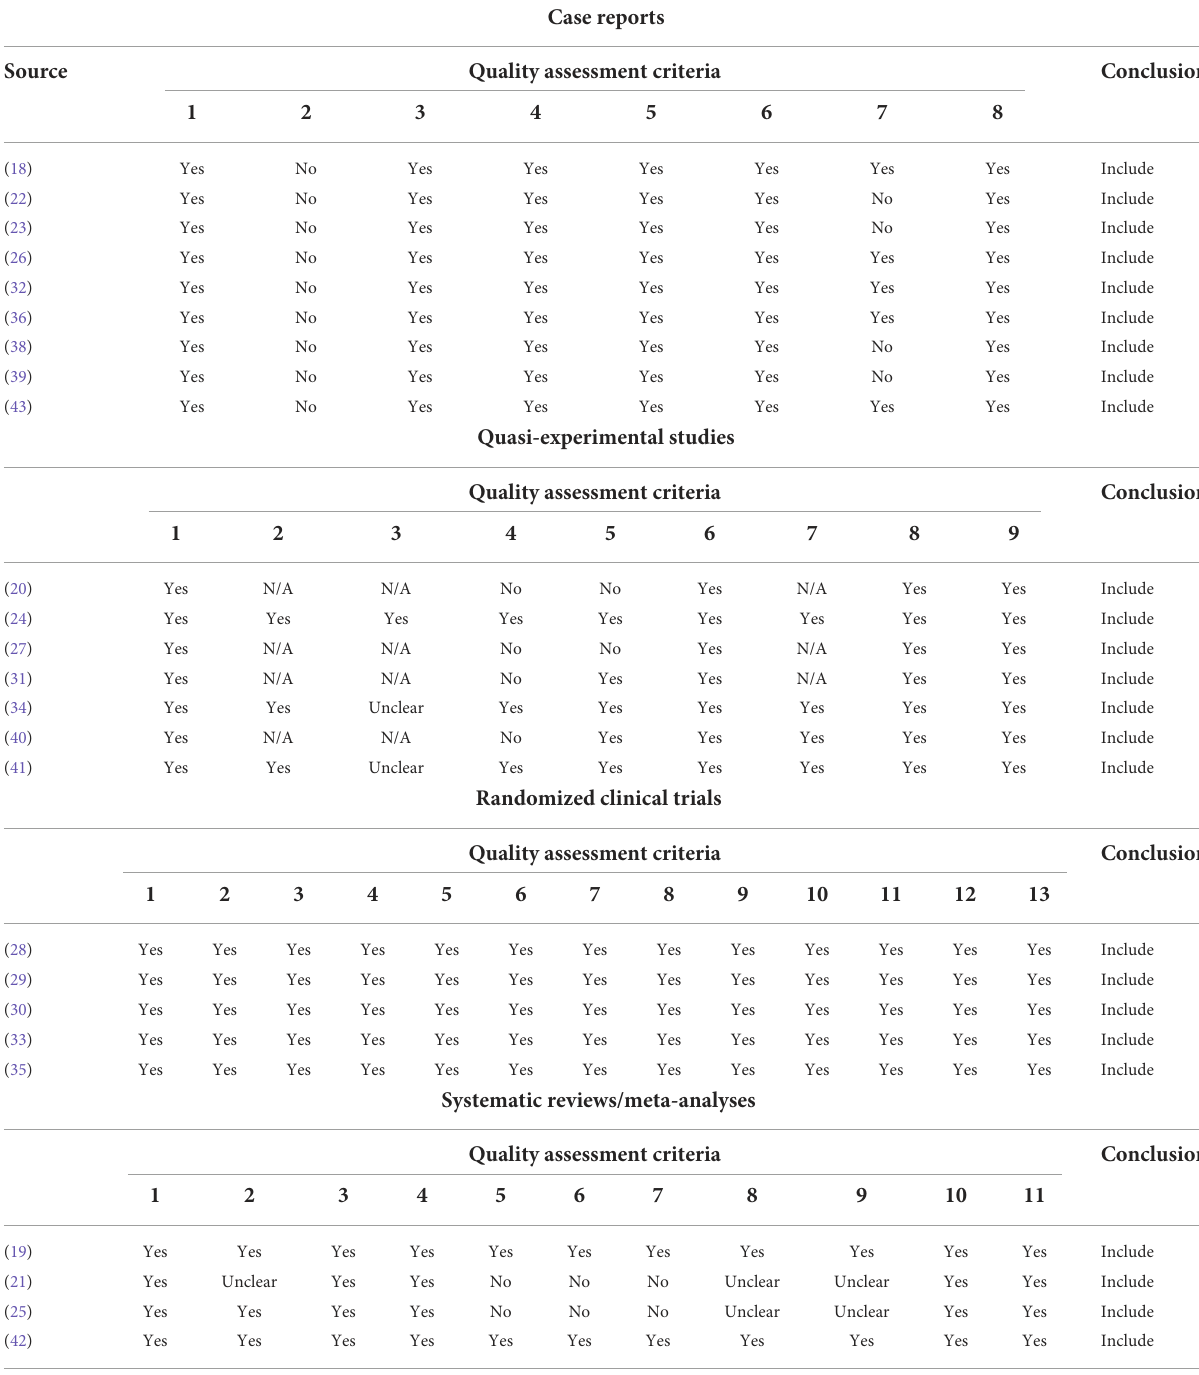
TABLE 4 Assessment of the quality of